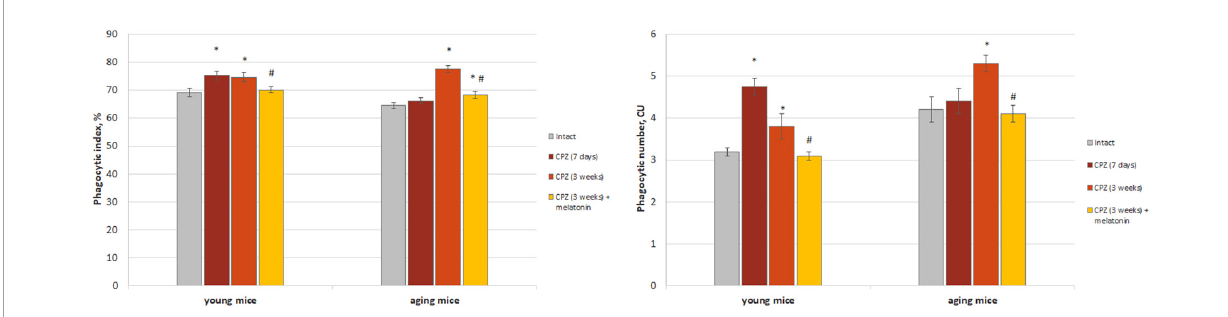
FIGURE2 The amount (phagocytic index) and activity (phagocytic number) of macrophages phagocytic latex beads in the brain of young and aging mice of experimental groups ( n = 5 in each group). Represented data are in 7 days and 3 weeks of cuprizone (CPZ) diet. Data are M ± SEM. ∗ p < 0.05 compared to intact group; # p < 0.05 compared to 3 weeks of CPZ ( t -test).